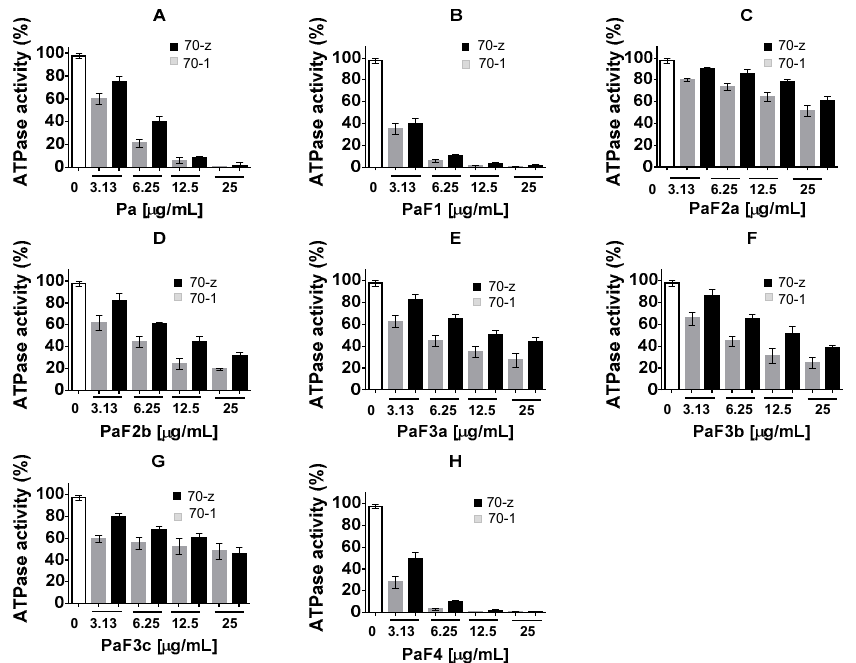
Figure 3. P. angolensis extracts inhibit the basal ATPase activity of PfHsp70-1 and PfHsp70-z. The basal ATPase activities of PfHsp70-1 (70-1) and PfHsp70-z (70-z) were analysed in the presence of various plant extracts. The values were normalized to the basal ATPase activities of each protein obtained in the absence of plant extract. The effects of plant extract under variable concentrations were then investigated and represented: ( A ) Pa, ( B ) PaF1, ( C ) PaF2a, ( D ) PaF2b, ( E ) PaF3a, ( F ) PaF3b, ( G ) PaF3c, ( H ) PaF4. Standard deviations obtained from three replicate assays are shown.